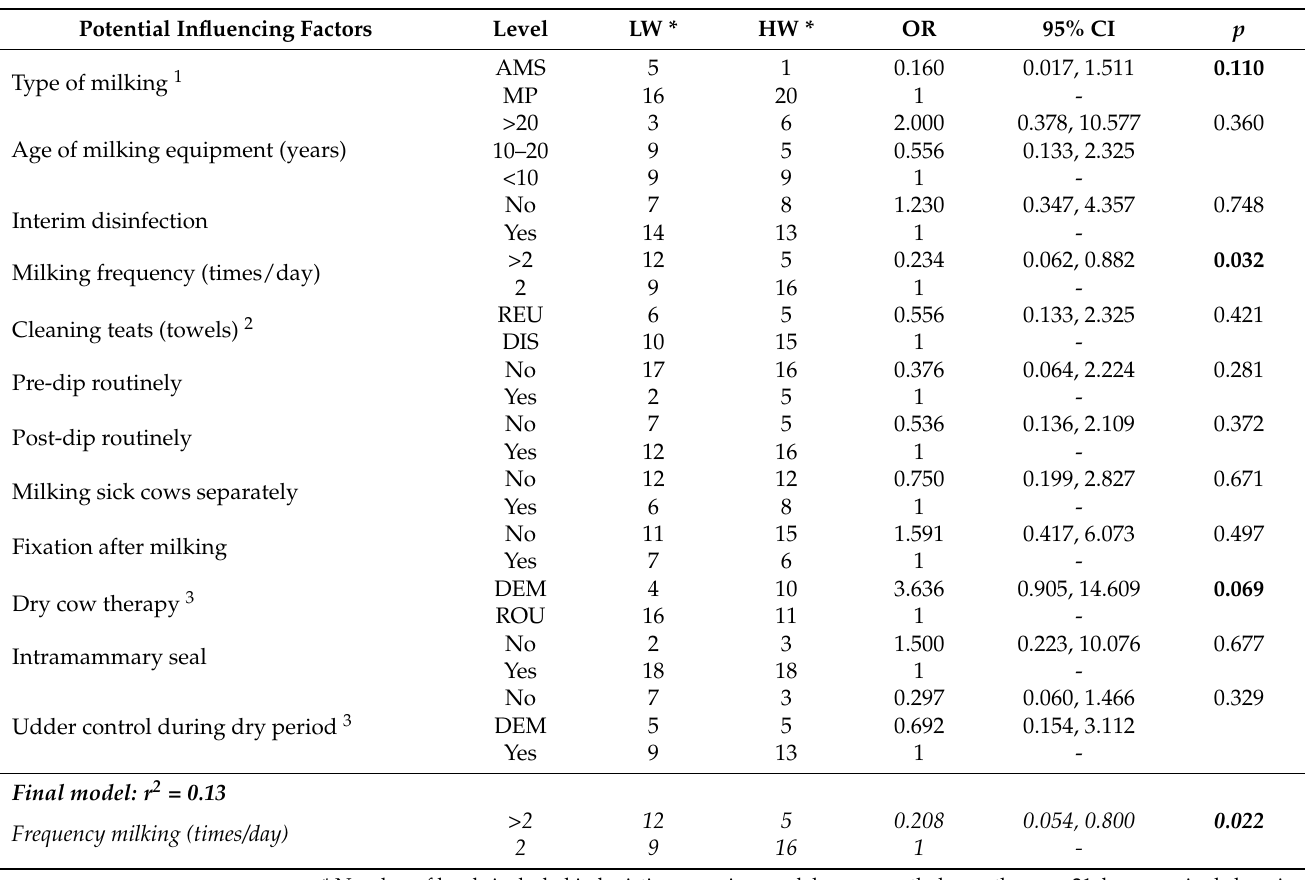
Table 7. Potential influencing factors in univariable logistic regression analysis associated with being a herd with high welfare level (HW) within the indicator “milk somatic cell count” [Odds ratio, confidence interval, bold p -values ( p < 0.20) were included in multivariable analyses; final model presented at the bottom of the